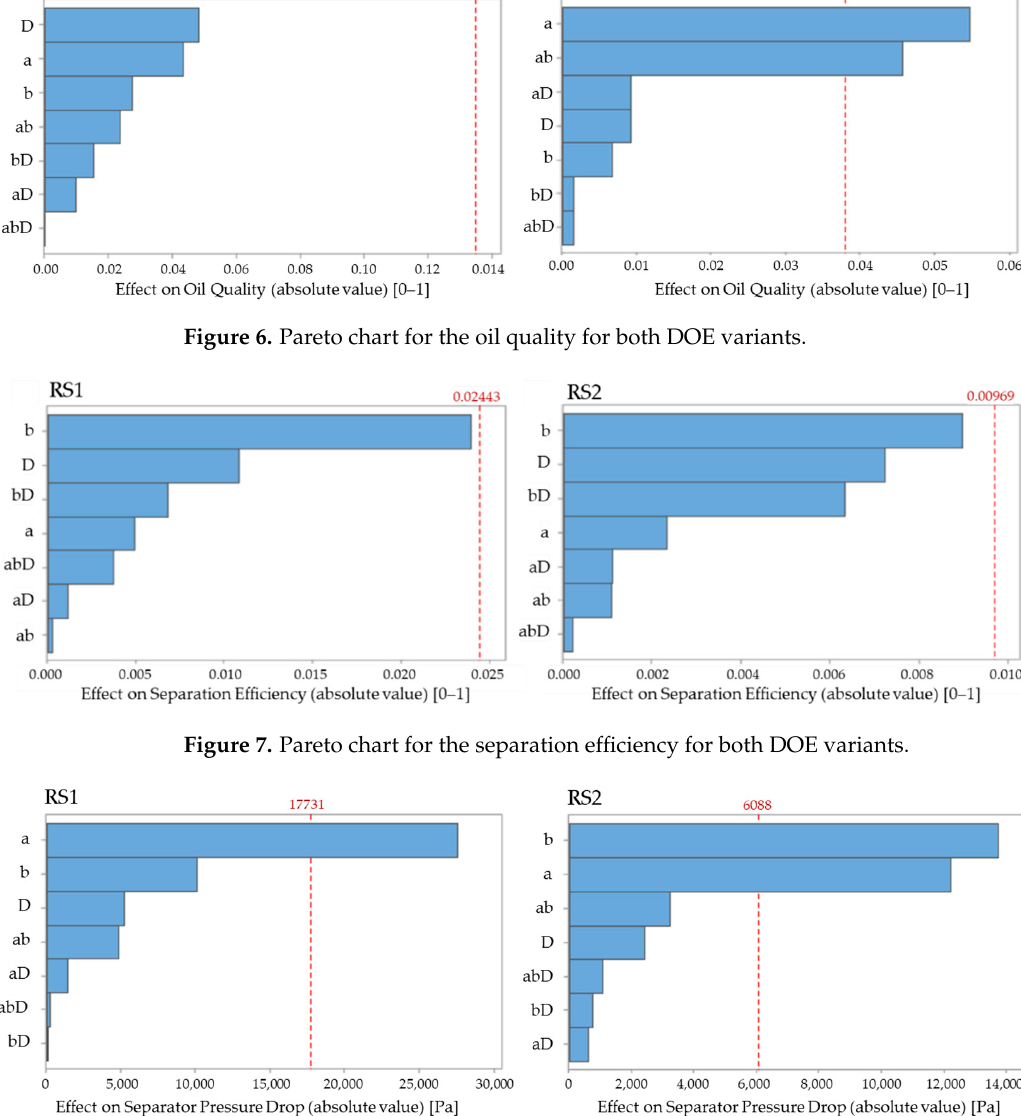
Figure 8. Pareto chart for the pressure drop for both DOE variants.